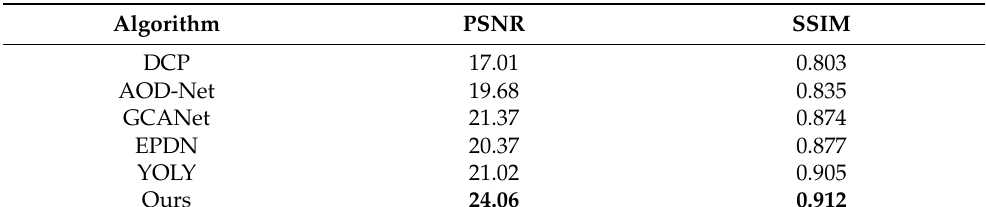
Table 4. Quantitative results on the HSTS.